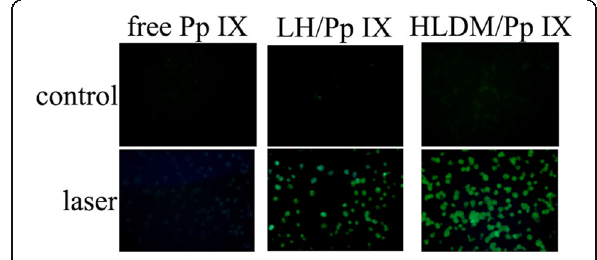
Fig. 7 Reactive oxygen species (ROS) generation under light